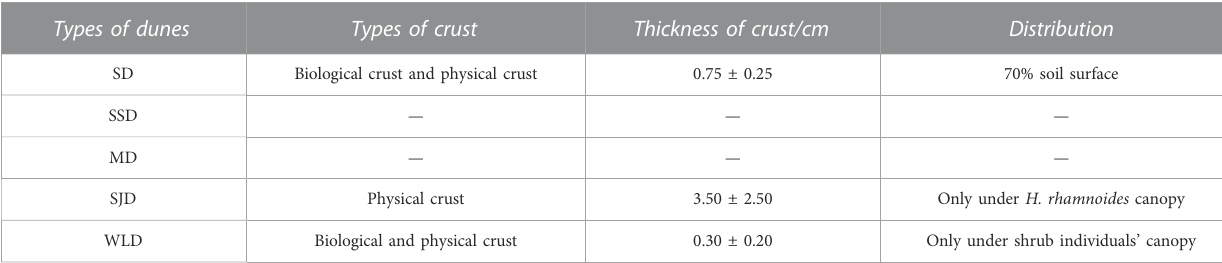
TABLE 7 Features of crusts in different types of dunes in the WPSER. Types of